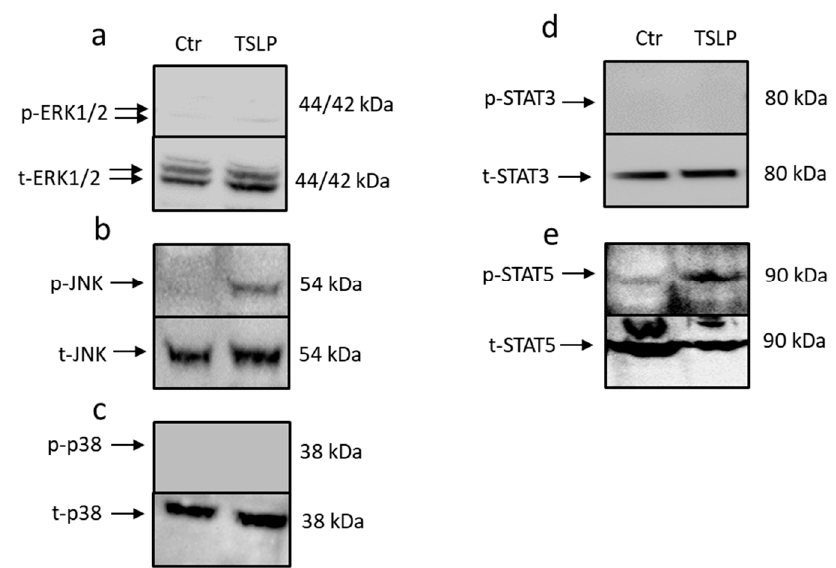
Figure 2. TSLP triggers the activation of signal transducer and activator of transcription (STAT)-5 and c-Jun-N-terminal kinase (JNK). The impact of TSLP treatment (at 7.5 ng / mL) on proximal signaling events after 30 min, as assessed by Western blotting using antibodies for ( a ) phospho (p) extracellular signal–regulated kinases (ERK)1 / 2 (n = 3), ( b ) pJNK, ( c ) pp38, ( d ) pSTAT3, and ( e ) pSTAT5 (shown are representative Western blots out of three independent experiments). The respective total (t) protein antibodies served as loading controls. Undetectable signals were negative also in time-course experiments.